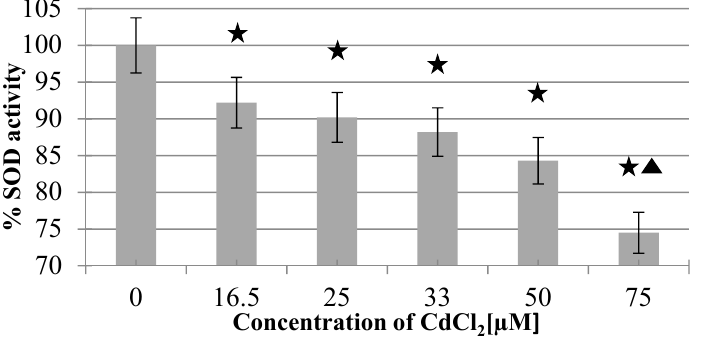
Figure 3. Inhibition of Cu,Zn-SOD activity upon 30 min of preincubation with aqueous CdCl 2 solution at 30 ◦ C. The asterisk marks statistically significant differences compared with the SOD activity without CdCl 2 . The triangle marks a statistically significant difference compared with the SOD activity in the presence of 16.5, 25, and 33 µ M CdCl 2. ( p < 0.05). Upon addition of CdTe QDs to the reaction mixture, the rate of epinephrine autooxida- tion decreased. No changes in autooxidation rate were noticed after preincubation of SOD1 (40 ng/mL) with QDs in a concentration of 60.03 µM or 73.37 µM. However, prein-